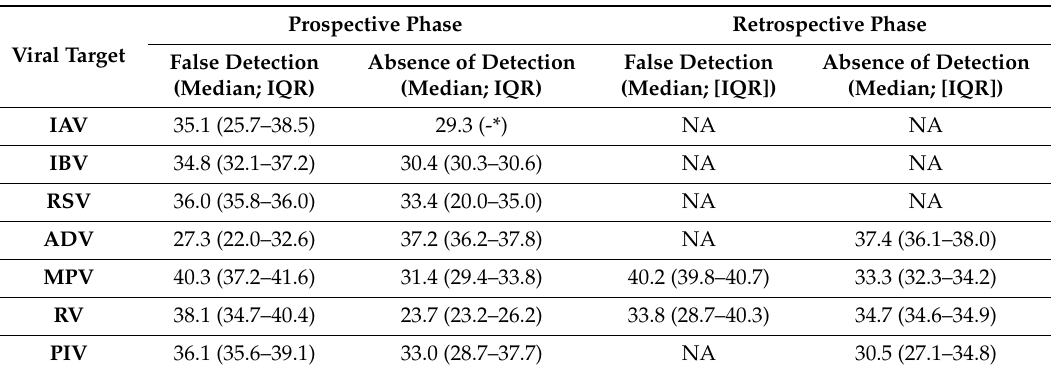
Table 4. Ct values of discrepant results. IQR: inter quartile range; -*: data not calculated (one